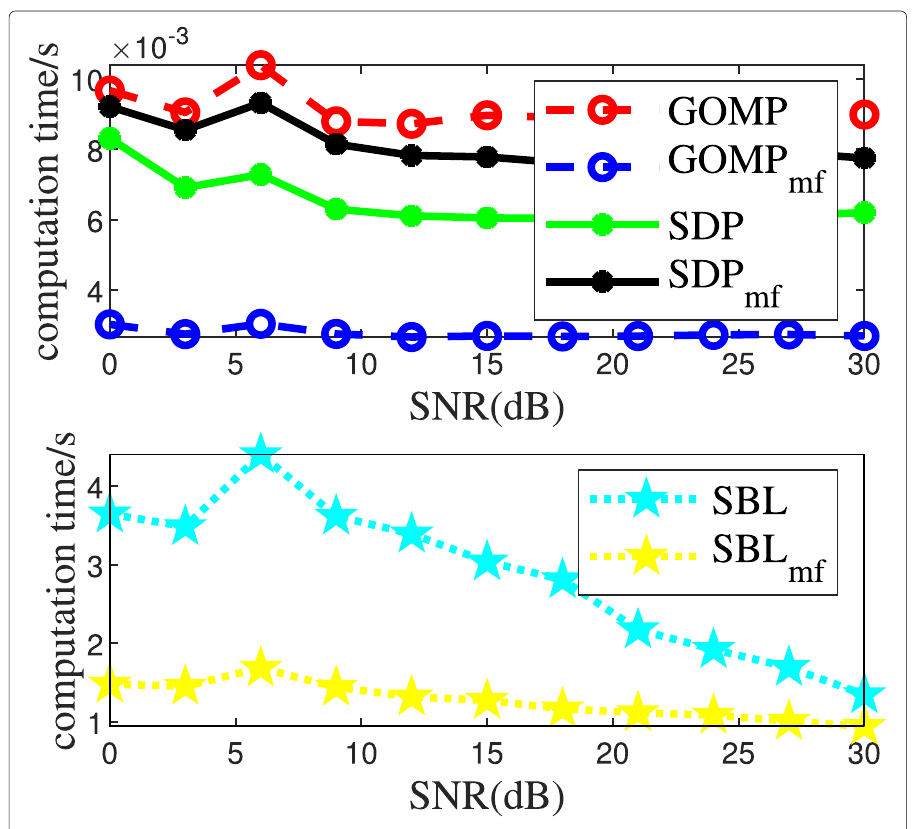
Fig. 3 Resolution probability by different methods vs. SNR